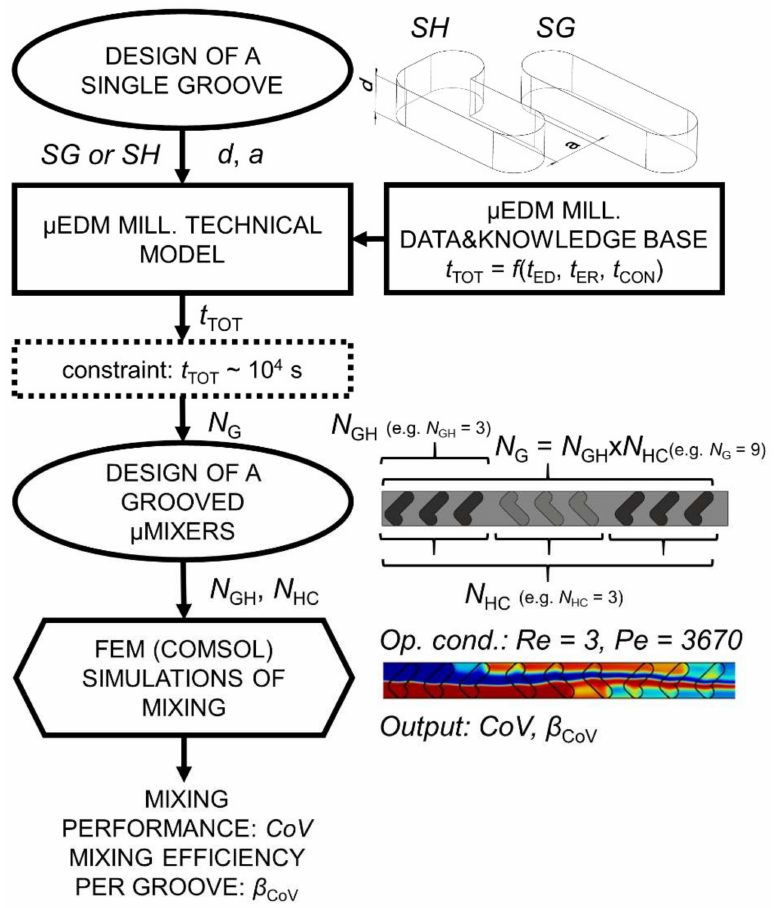
Figure2. Investigationworkflow. Denotations: SH —staggeredherringbonegroovedesign, SG —slanted groove design, d —groove depth, a —groove width, t ED —electrode dressing time, t ER —erosion time, t CON —electrode wear control time, t TOT —overall machining time, N G —number of grooves in